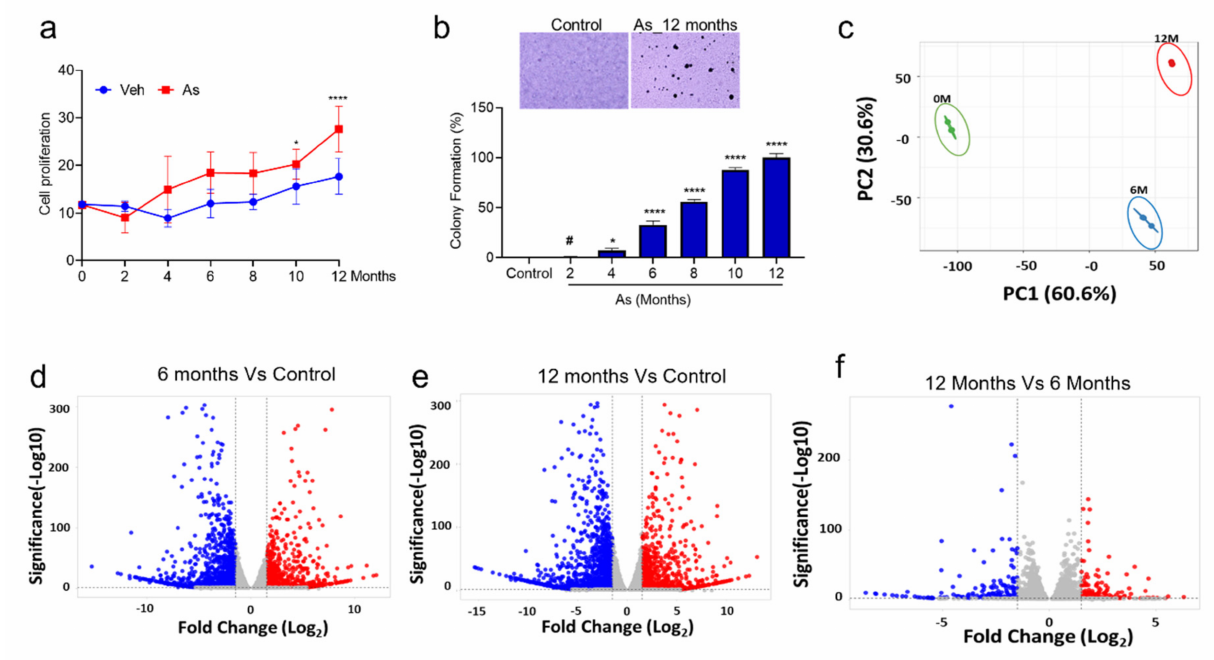
Figure 1. Determination of cell viability, colony formation ability of transforming cells, and identifica- tion of differentially expressed genes from RNA seq datasets. ( a ) The cell viability was measured